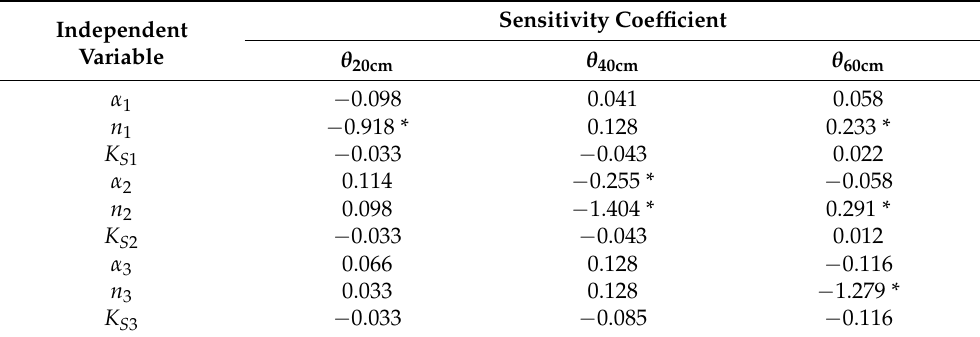
Table 4. Sensitivity analysis of parameters α , n and K s to water content of 20 cm, 40 cm, and 60 cm soil